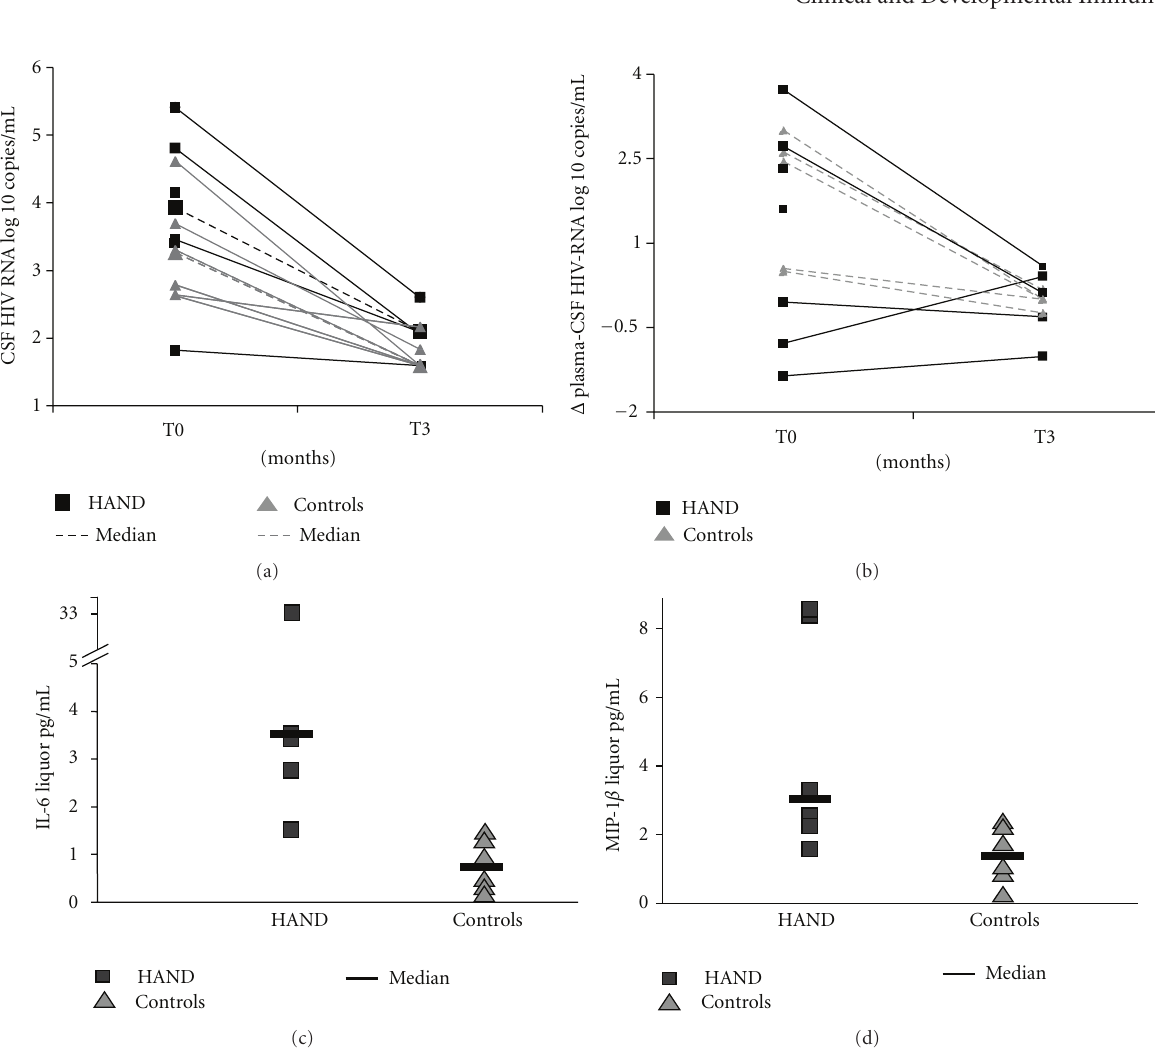
Figure 1: Representation of CSF HIV-RNA dynamics (a), di ff erence in HIV-RNA levels between plasma and CSF ( Δ ) (b) and cytokines (IL-6, MIP-1 β ) concentrations at baseline. At baseline and after 12 weeks of ART, CSF HIV-RNA was not di ff erent between HAND patients and controls (Figure 1(a)). Di ff erence in HIV-RNA levels between plasma and CSF ( Δ ), both at baseline and at week 12, showed a value > 0.5log copies/mL in 3/4 patients in the HAND group and in 1/5 in the control group, reflecting a slower decrease in HIV-RNA level in CSF as compared to plasma in HAND patients (Figure 1(b)). At baseline concentration of MIP-1b and IL-6 in CSF, there was a di ff erence between the two groups of patients (Figure